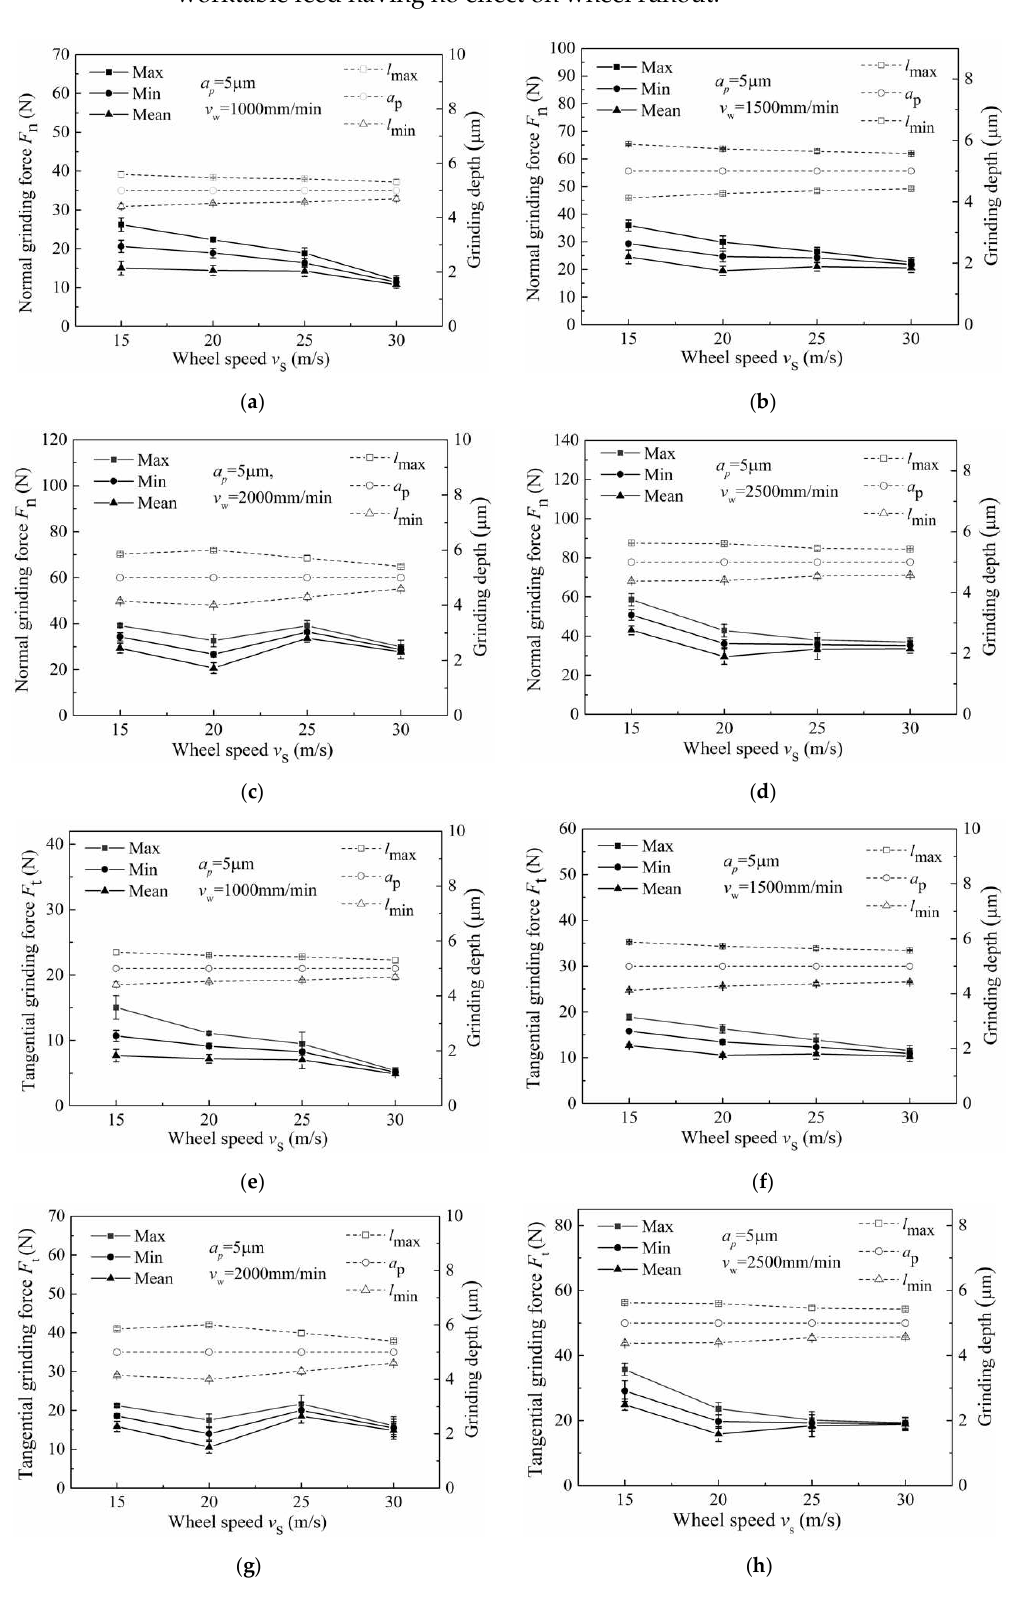
Figure 8. Influence of wheel speed on ( a – d ) normal grinding force and grinding depth and ( e – h ) tangential grinding force and grinding depth.